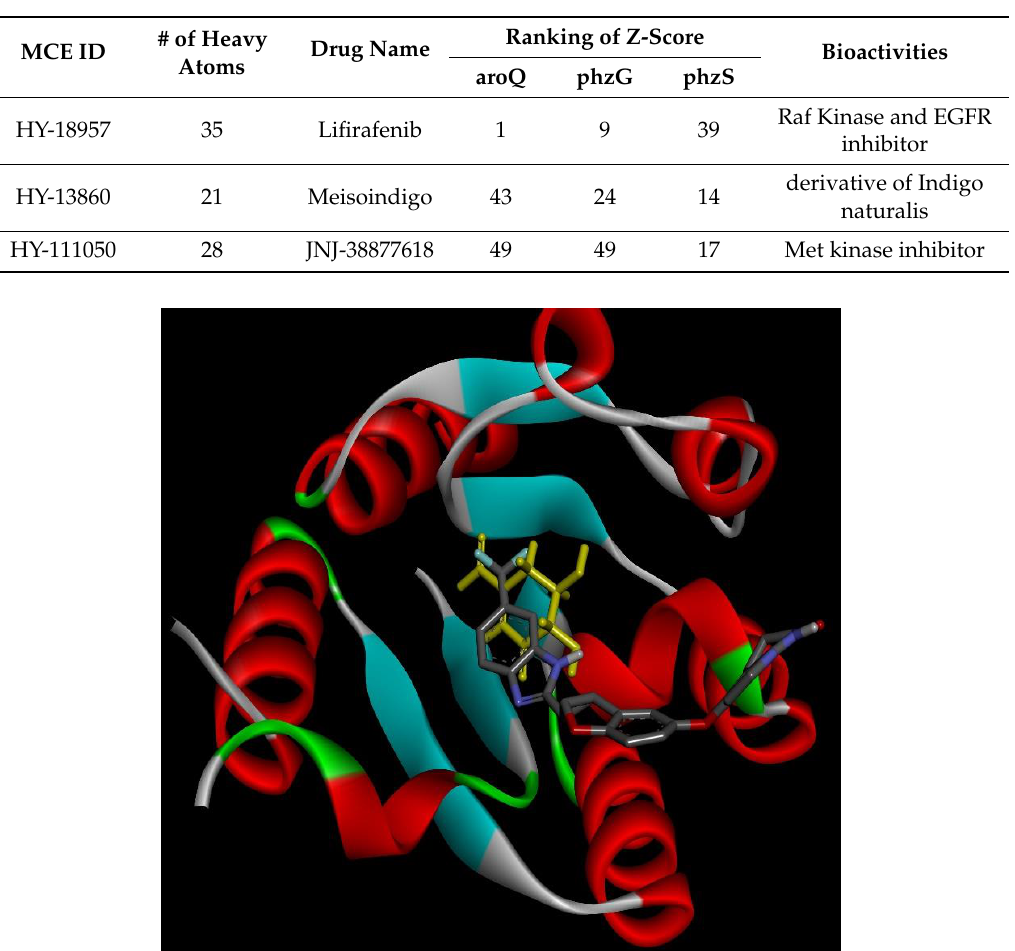
Table 1. Consensus ranking of normalized docking score on aroQ, phzG and phzS.